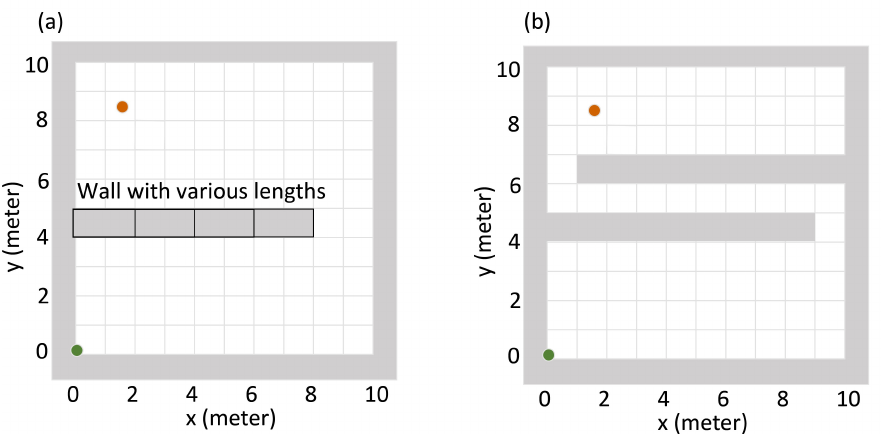
Figure 5. Illustration of the simulation areas in the detector trapping test. Green dots represent the initial point of the detector, and red dots represent the position of the radiation source. Grey areas represent the walls which can block the source’s radiation entirely. Plot ( a ) shows the first kind of simulation area, in which the wall is attached to the left edge of the simulation area and has different lengths (0 m, 2 m, 4 m, 6 m, 8 m). The longer the wall is, the harder it is for the detector to move from lower part to the upper part. All these wall configurations have been seen by the Q-learning algorithm in the training stage. Plot ( b ) shows the second kind of the simulation area. This wall configuration has not been seen by the Q-learning algorithm in the training